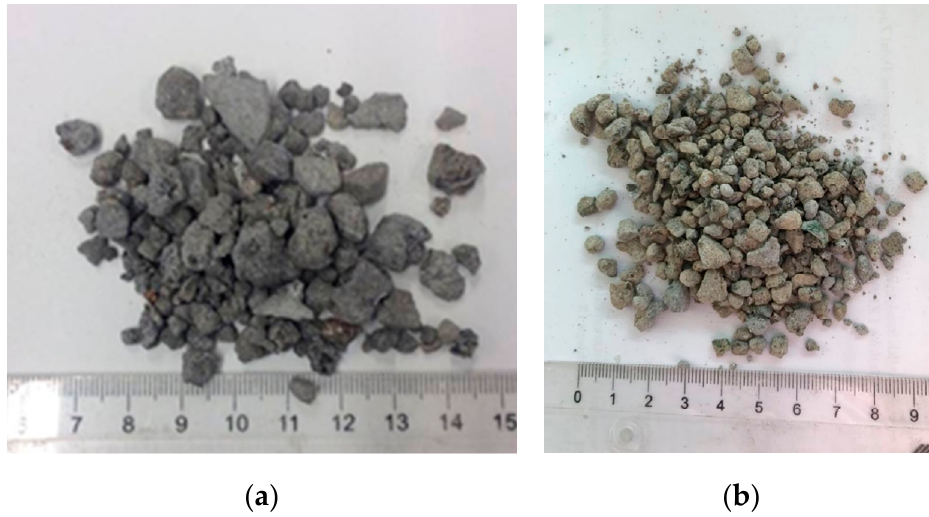
Figure 5. Secondary waste from an incineration plant: ( a ) municipal solid waste incineration bottom ash